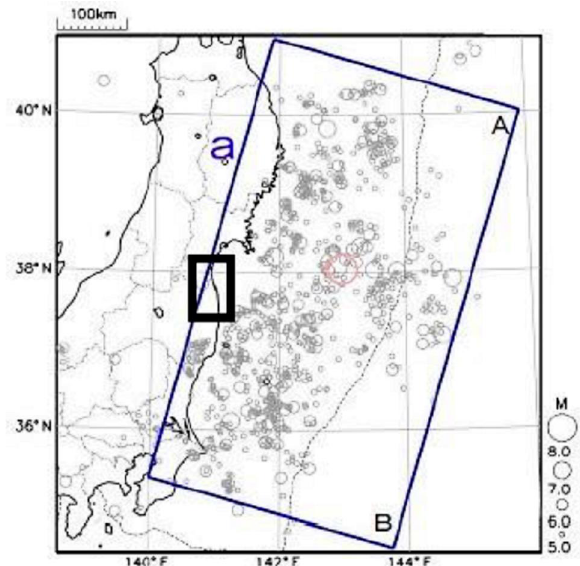
Figure1. the epicenters distributed off the Pacific coast (Japan Meteorological Agency,2014) and the research area (a central rectangle) shown in the eastern part of the Japanese Main